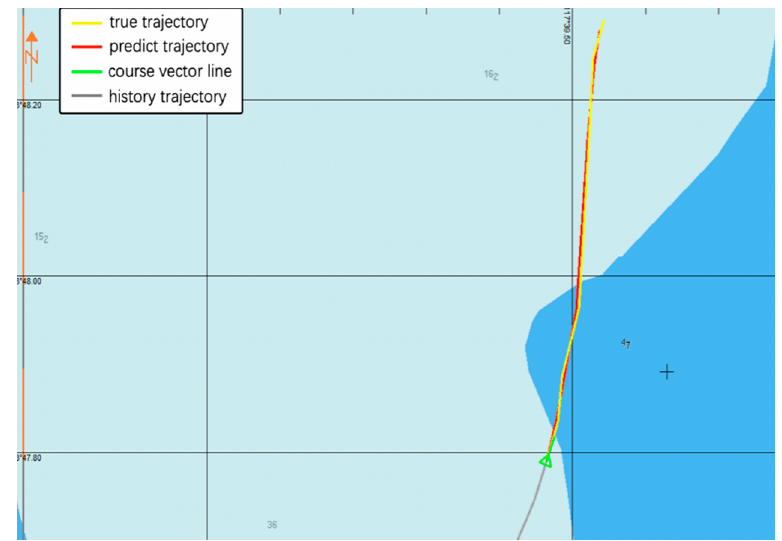
Figure 19. Visualization of the vessel’s real trajectory and predicted trajectory that uses the GRU model.